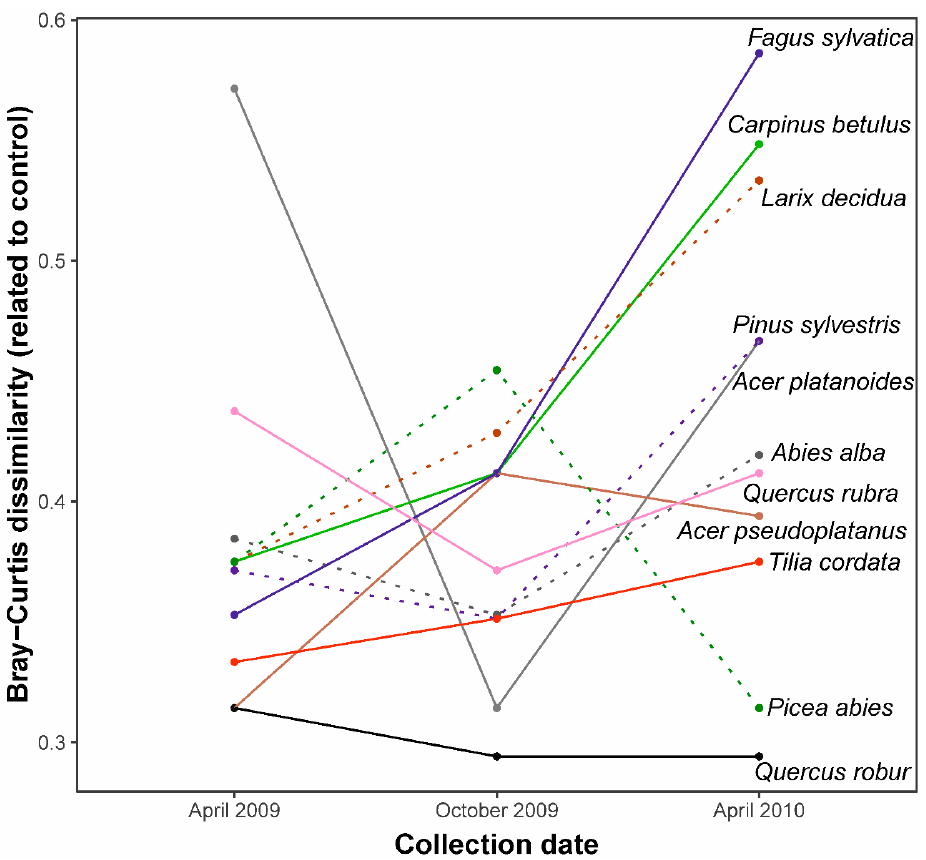
Figure 3. Dissimilarity between mite communities and the control (mite community in the soil during experiment setup), expressed by Bray-Curtis dissimilarity index. Solid line—broadleaved species; dashed line—coniferous species.